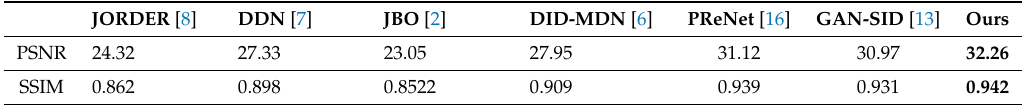
Table 4. Quantitative comparison results on DID-MDN dataset